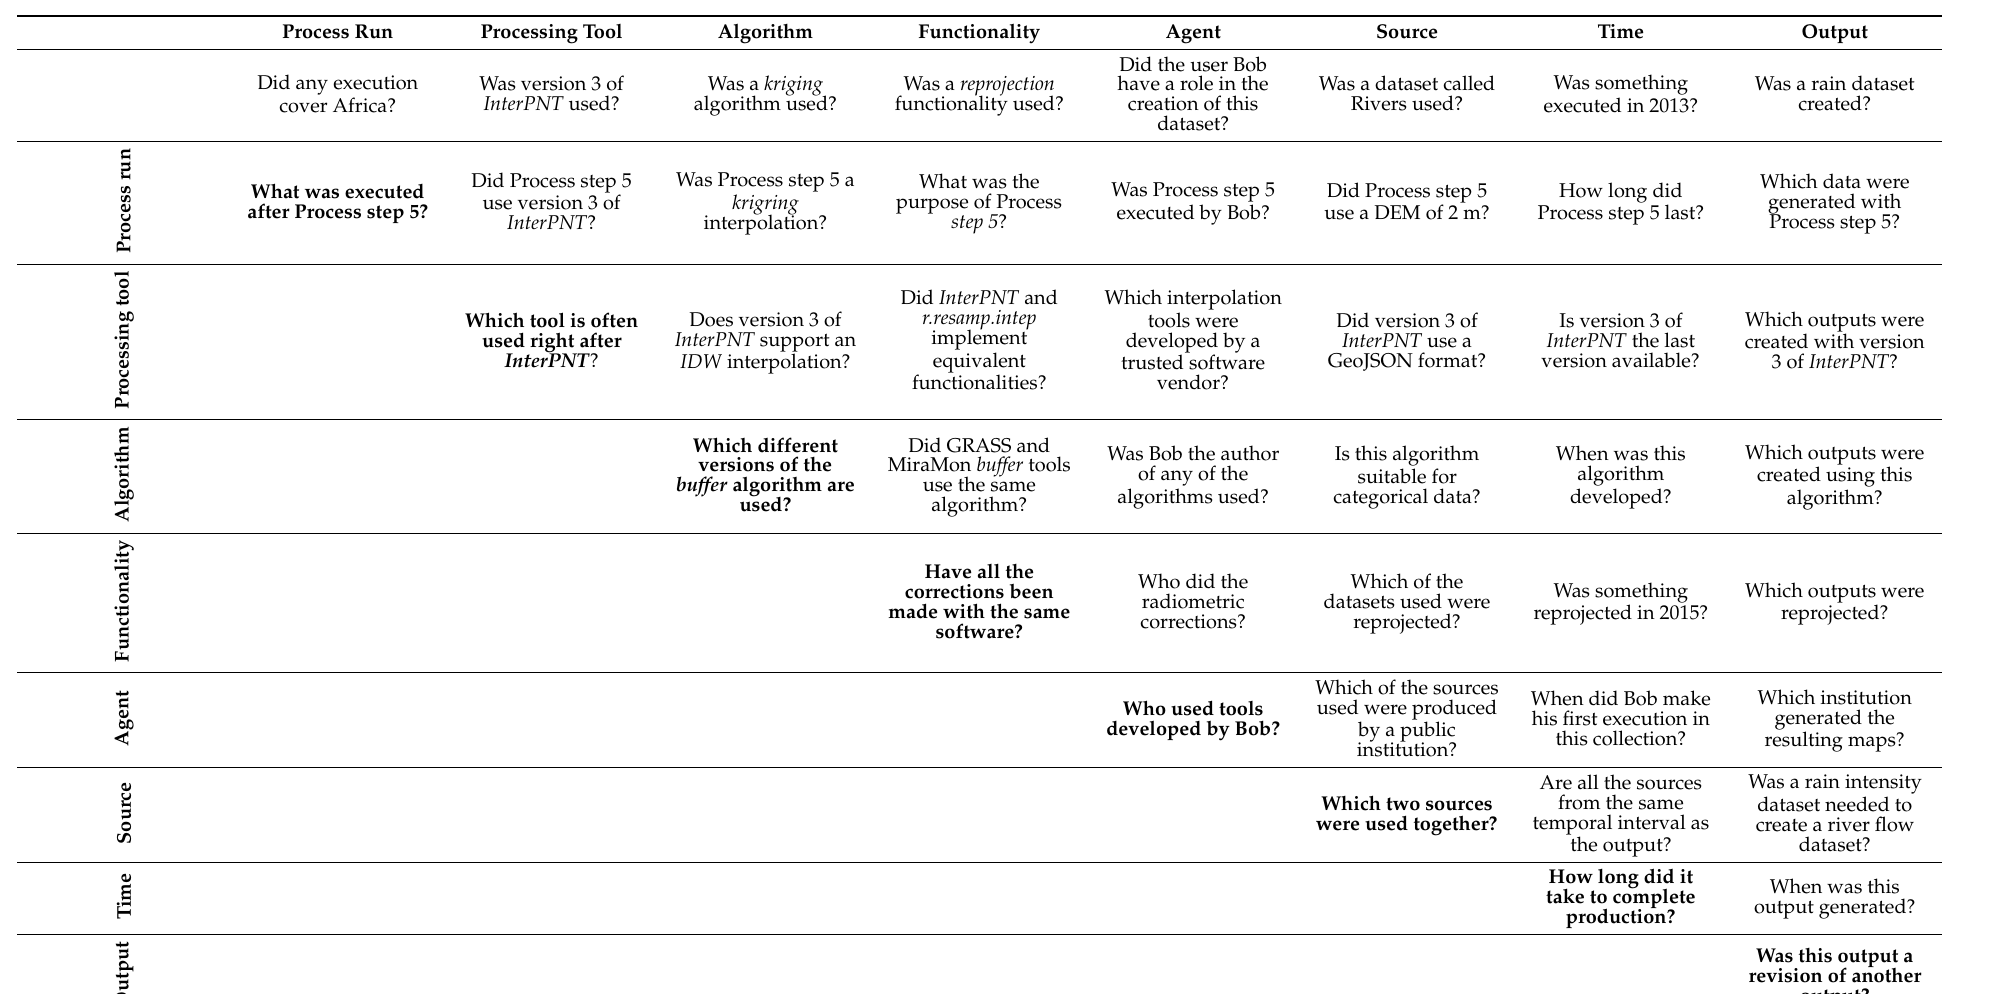
Table 3. Forty-four examples of queries about